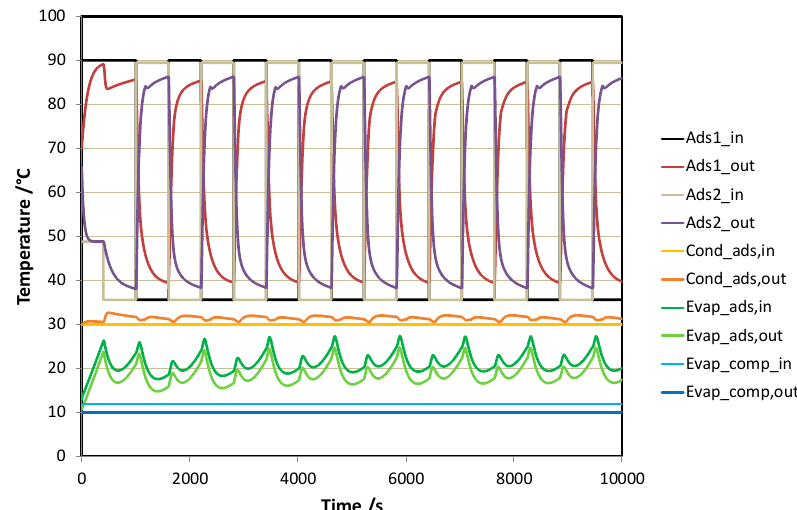
Figure 12. Temperatures in the circuits of the sorption module and heat pump for the reference conditions. The outlet of the evaporator of the adsorption unit (light green) also represents the inlet of the condenser in the vapour compression chiller; the inlet of the of the evaporator of the adsorption unit (dark green) also represents the outlet of the condenser in the vapour compression chiller.